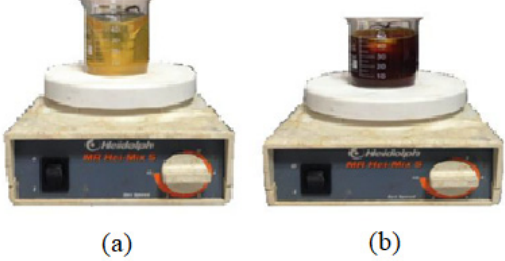
Fig. 1: Silver-cobalt nanoparticles synthesized by using of silver nanoparticles which prepared during 75 seconds, (a) before adding a reducing agent, (b) after adding a reducing agent